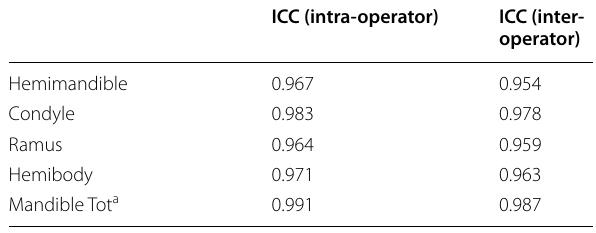
R right, L left, SD standard deviation a Sum between right hemimandible and left